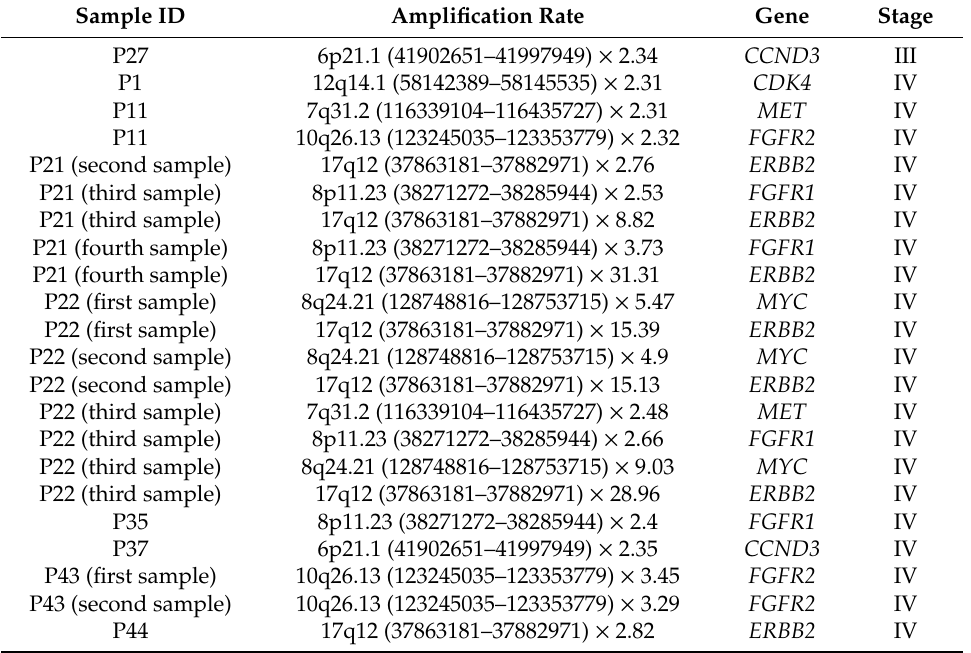
Table 5. Copy number variants detected in